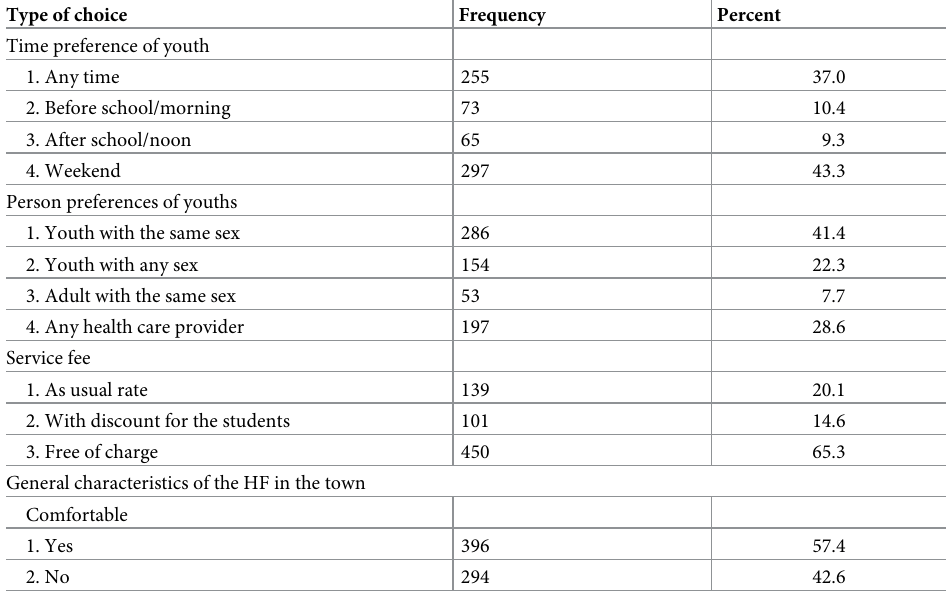
Table 3. Youths preferences to time, to health care providers, service fee and characteristics of health facility in Debre Tabor town, Northwest Ethiopia,